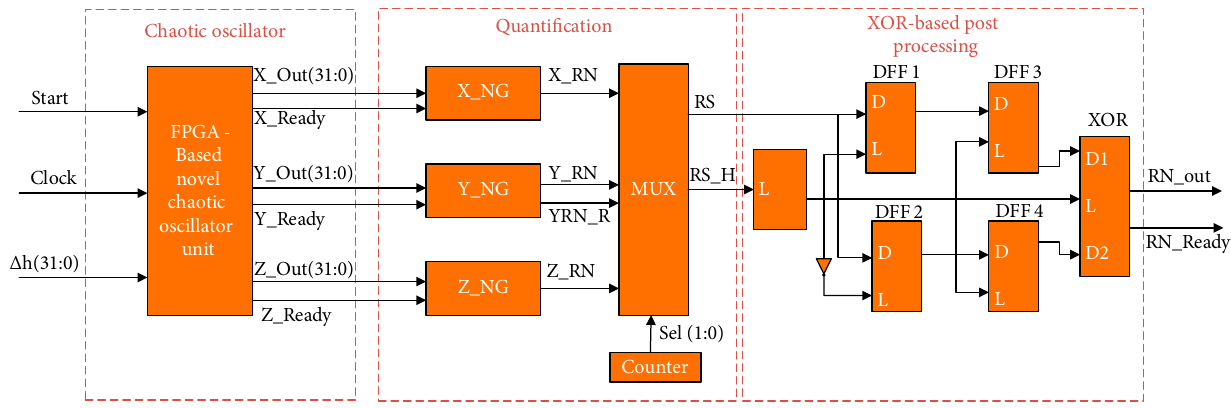
Figure 6: Block diagram of FPGA-based chaotic